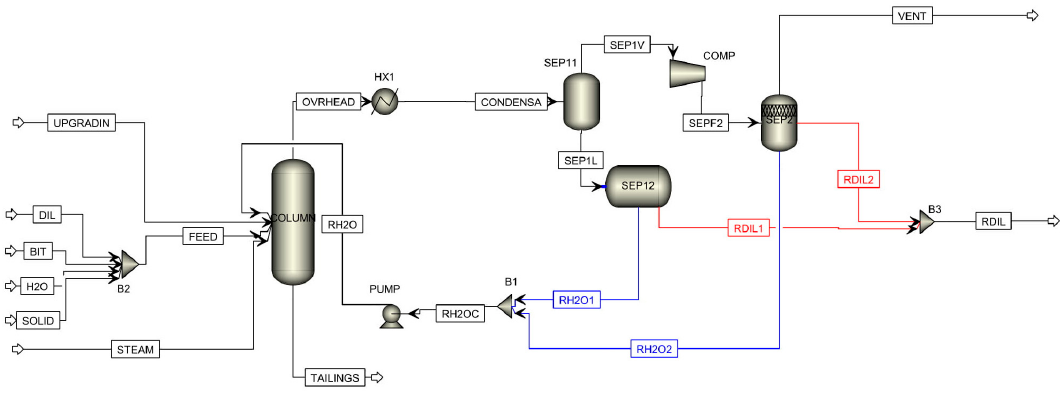
Figure 12. Configuration of the base case design for the overhead system. Table 6. Aspen Plus unit specifications for both base case and “withdraw and remix”